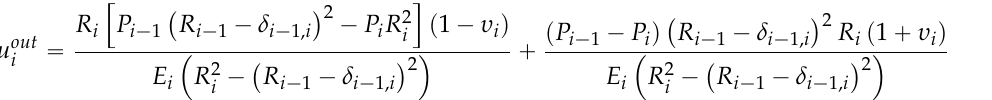
Figure 9. Calculation flow diagram for interference algorithm for multi-layer thick-walled cylinders (MTC) without consideration of assembly sequence.